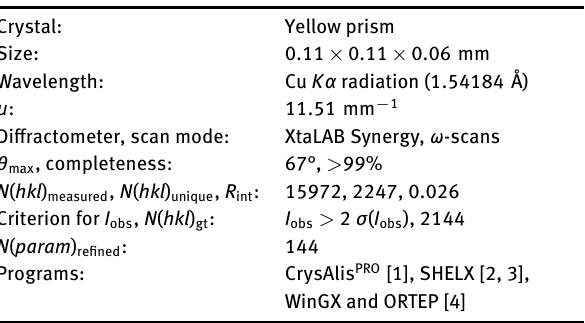
Table 1: Data collection and